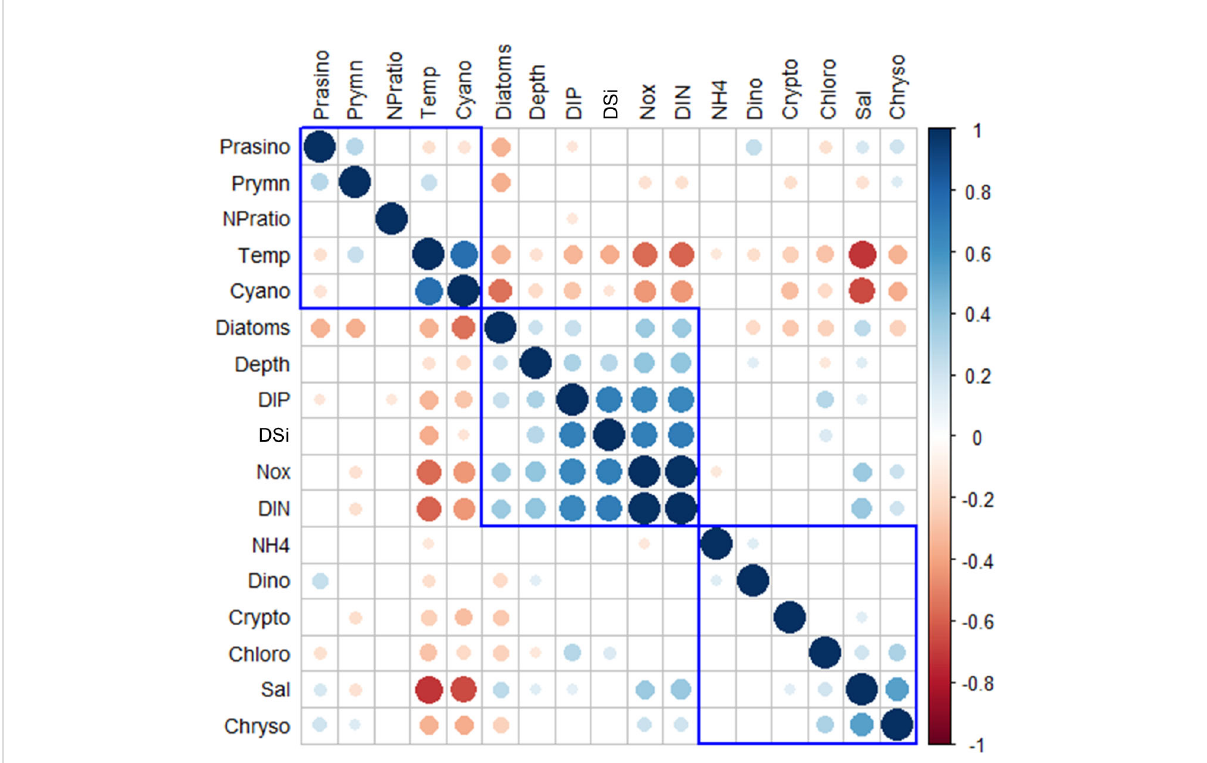
FIGURE 8 Heatmap of the correlation coef fi cients between the major phytoplankton communities and environmental drivers of each cruise period in the SCWK, 2018 ∼ 2020. Only signi fi cant coef fi cients and absolute correlation coef fi cients (if >0.10) are indicated. The size of a circle indicates the absolute correlation coef fi